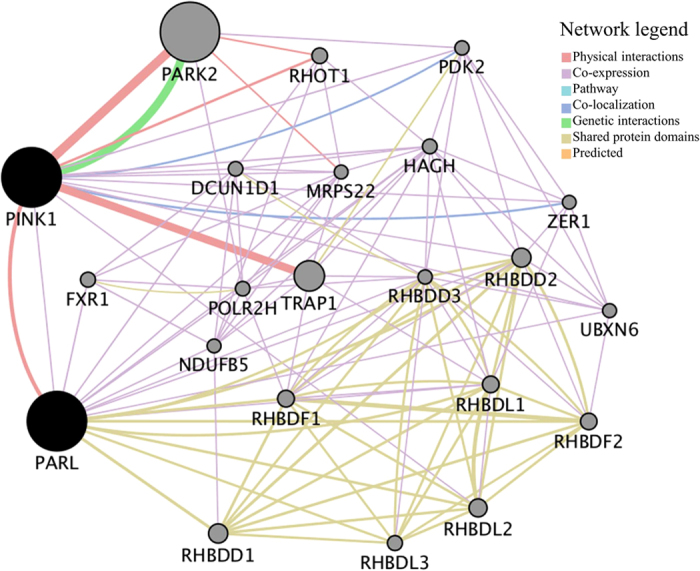
Protein interaction network of the PARL and PINK1 genes.PARL can directly interact with PINK1 according to the GeneMANIA database (http://genemania.org/)41. The minimum required interaction score is >0.7 and the line thickness indicates the strength of data support.